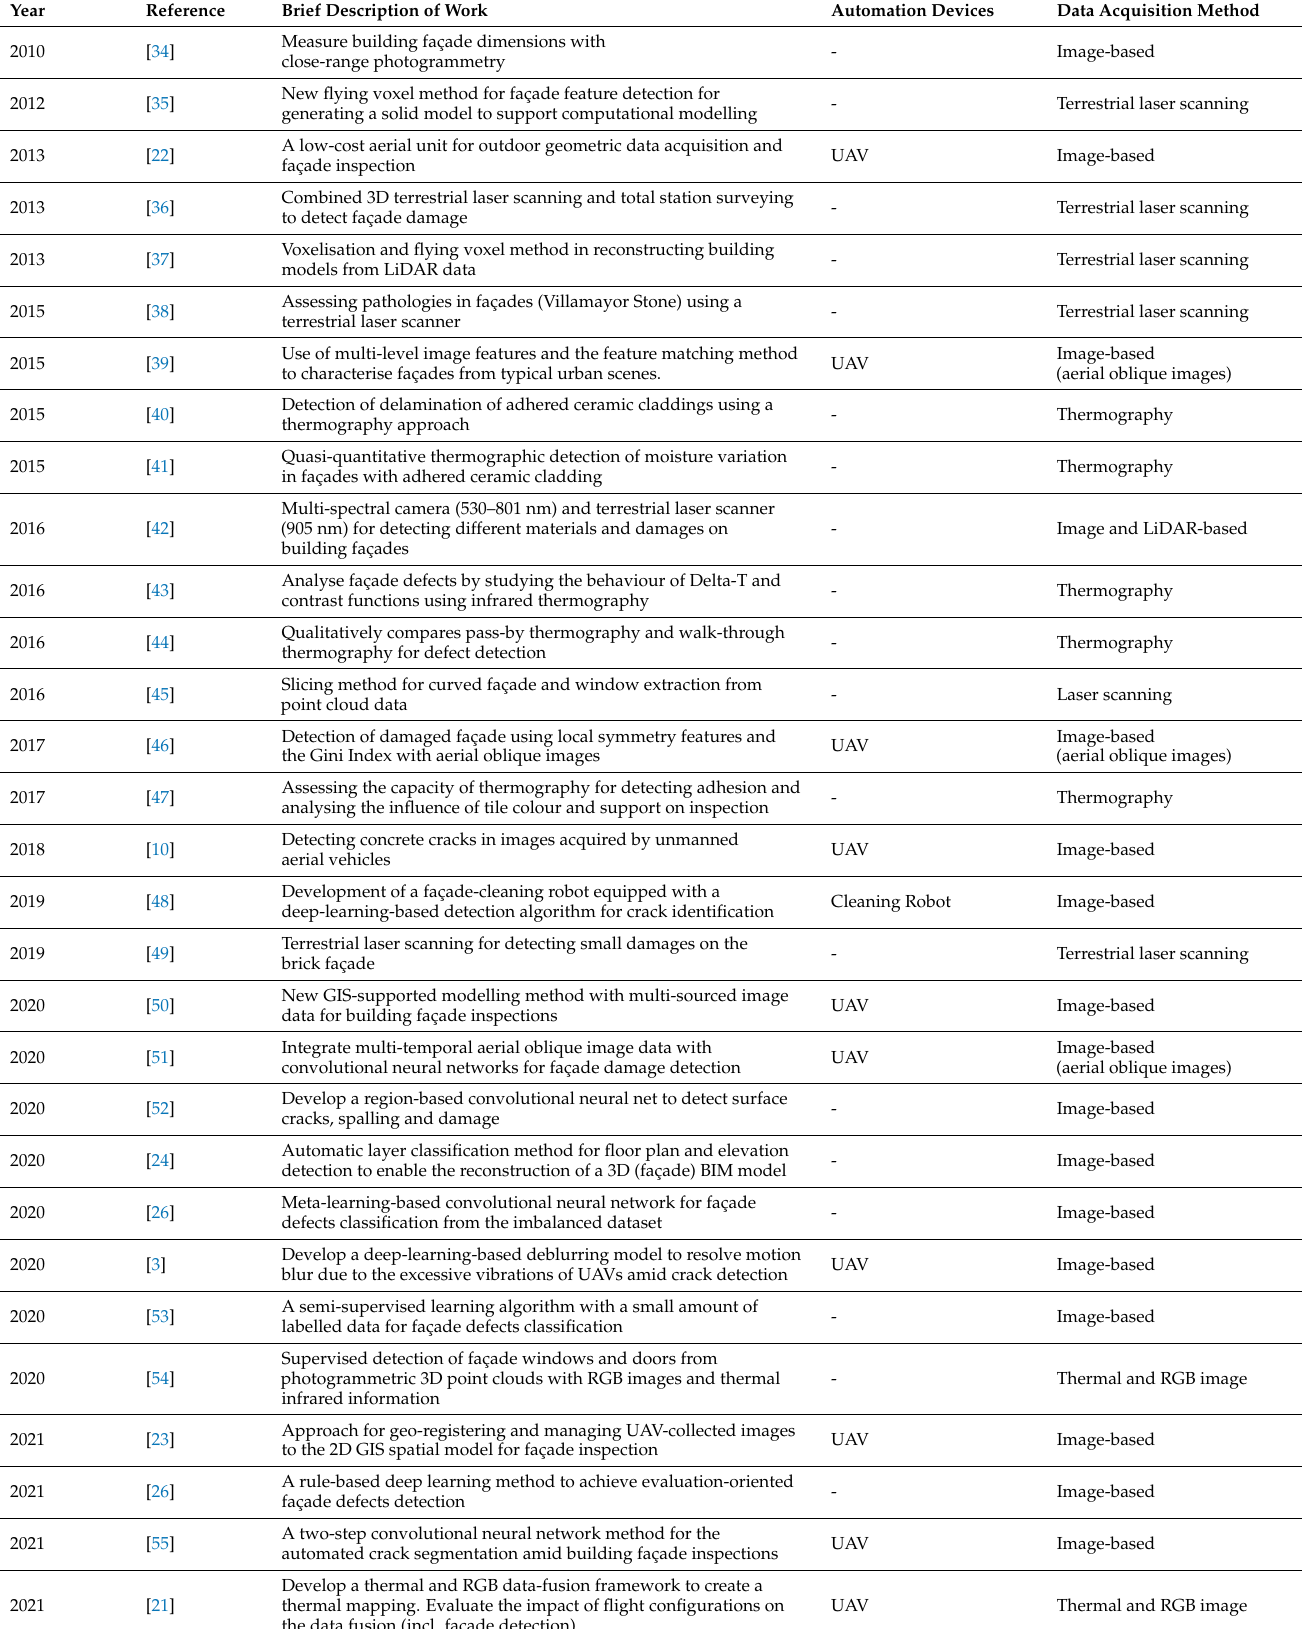
Table 3. Selected peer-reviewed articles on automated façade